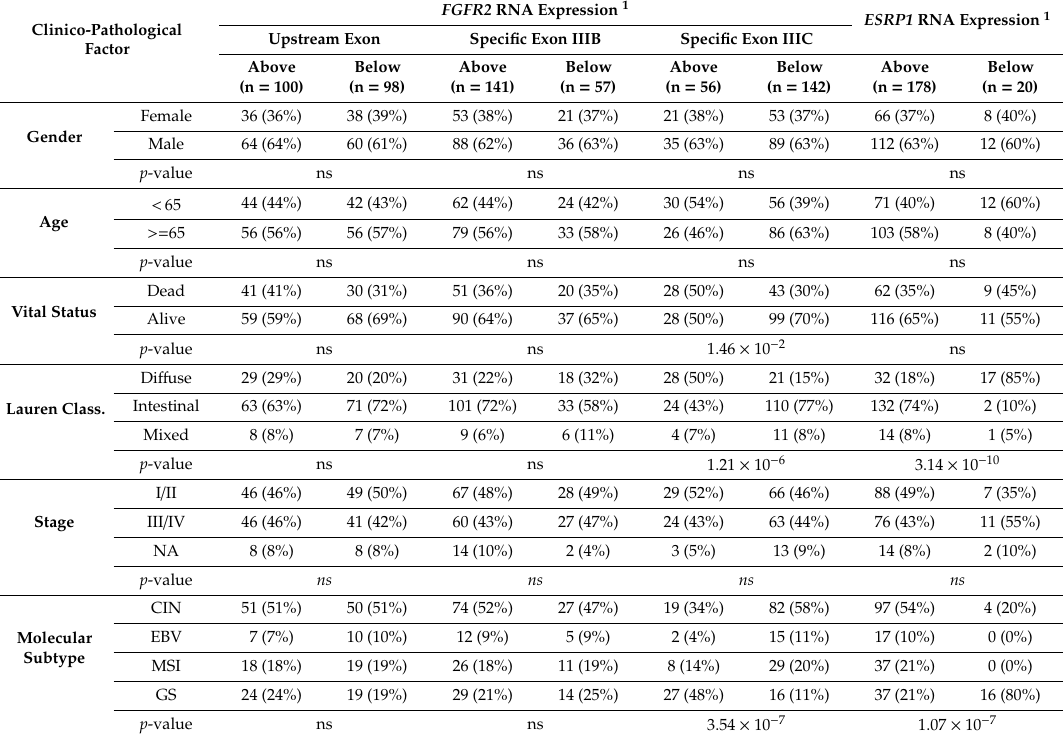
Table 1. Clinico-pathological factors and expression of FGFR2 distinct exons and ESRP1 in cohort #1 dataset #11 gastric